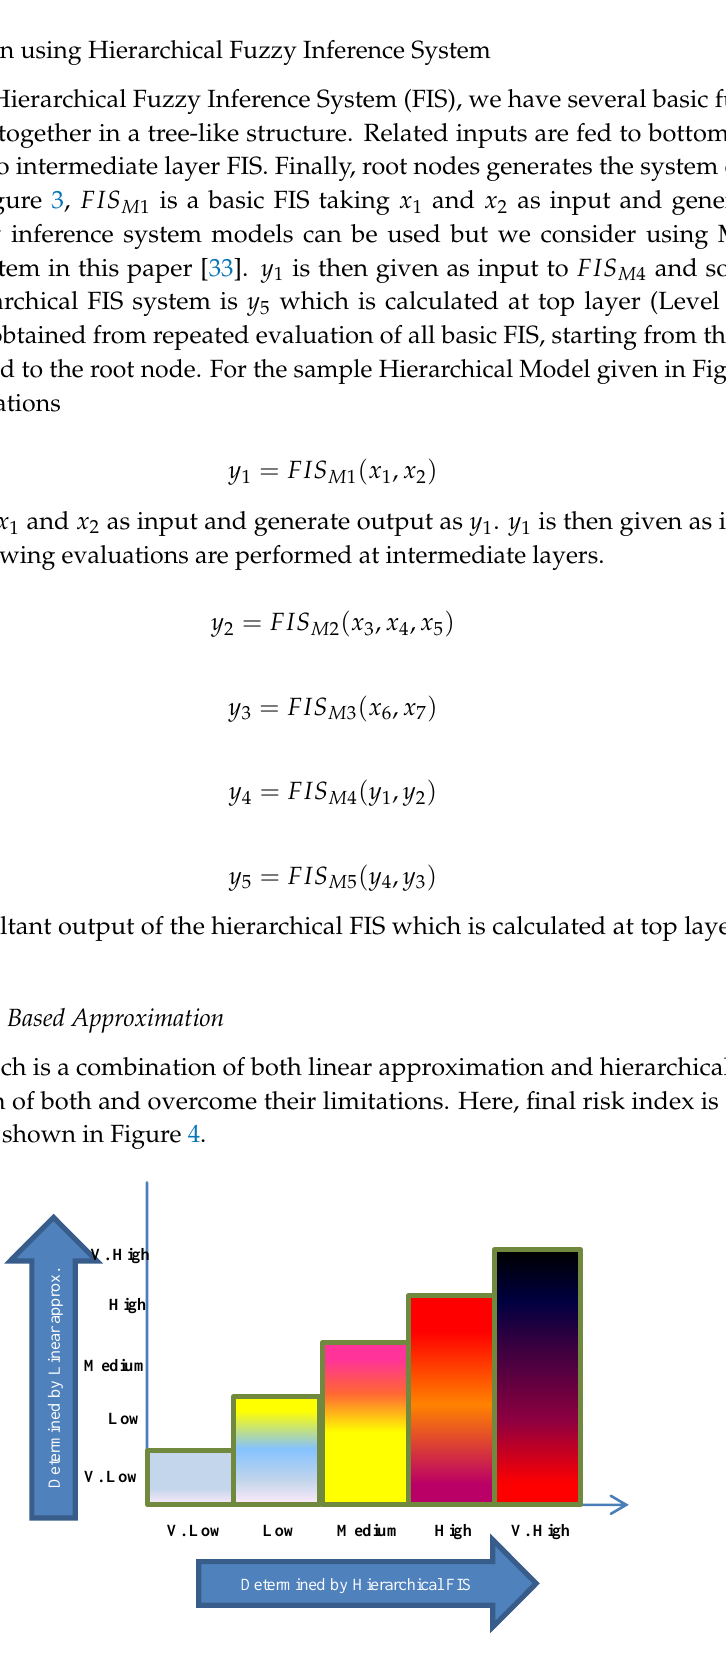
Figure 4. Risk index mapping using hybrid